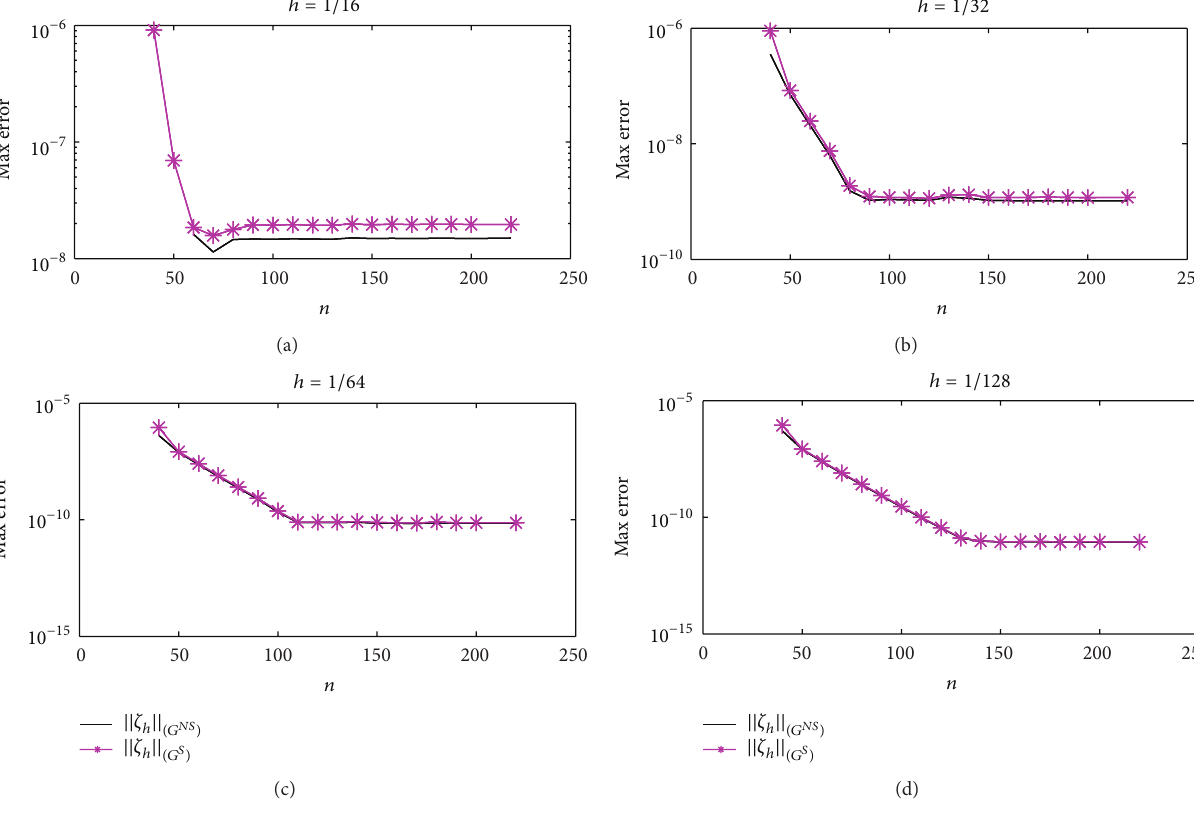
Figure 5: Maximum error depending on the number of quadrature nodes 𝑛 .